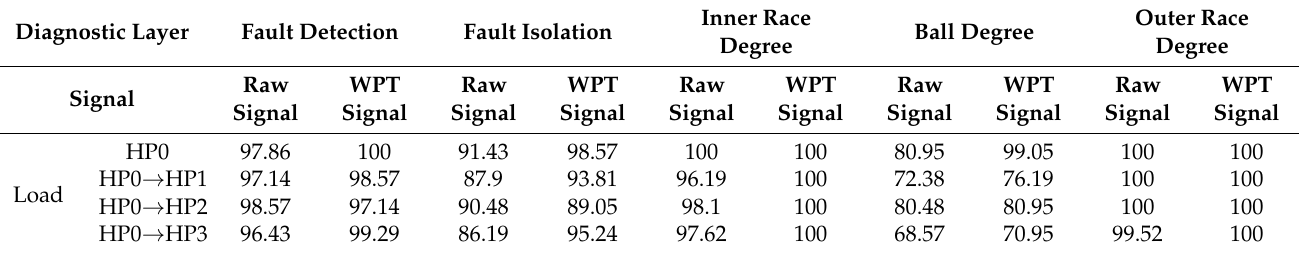
Table 7. Diagnosis result under variable load